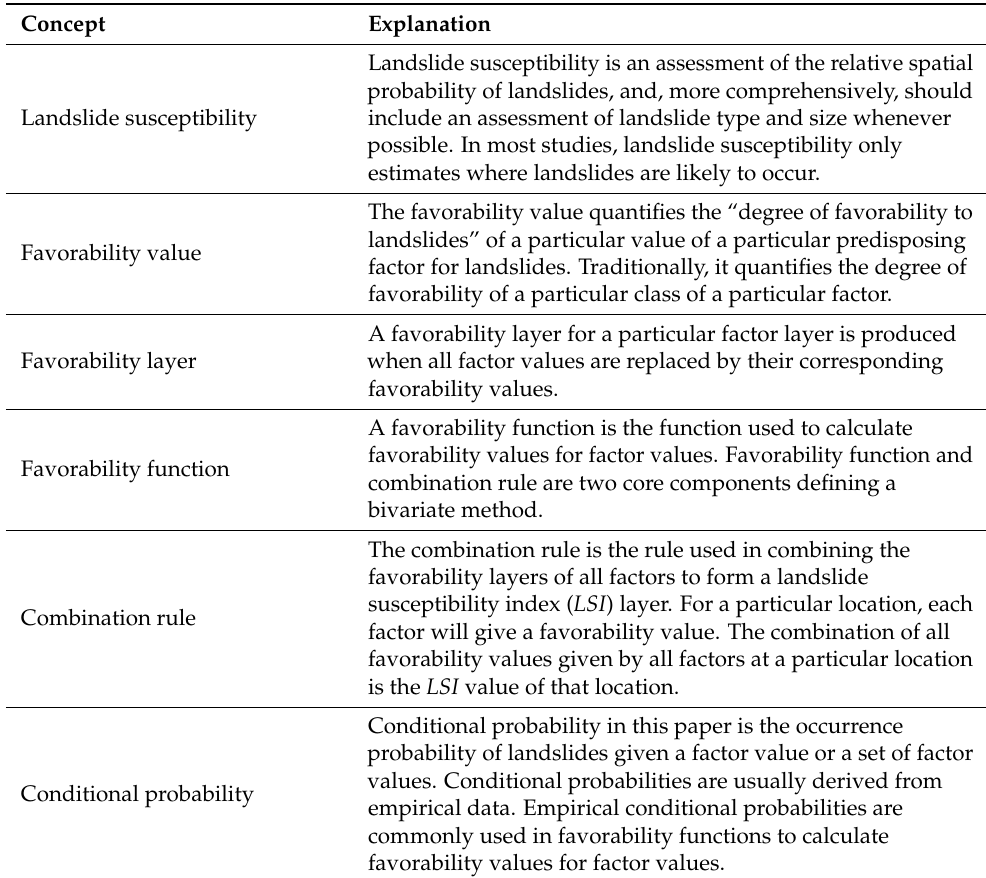
Table 2. A collective explanation of the major concepts involved in this